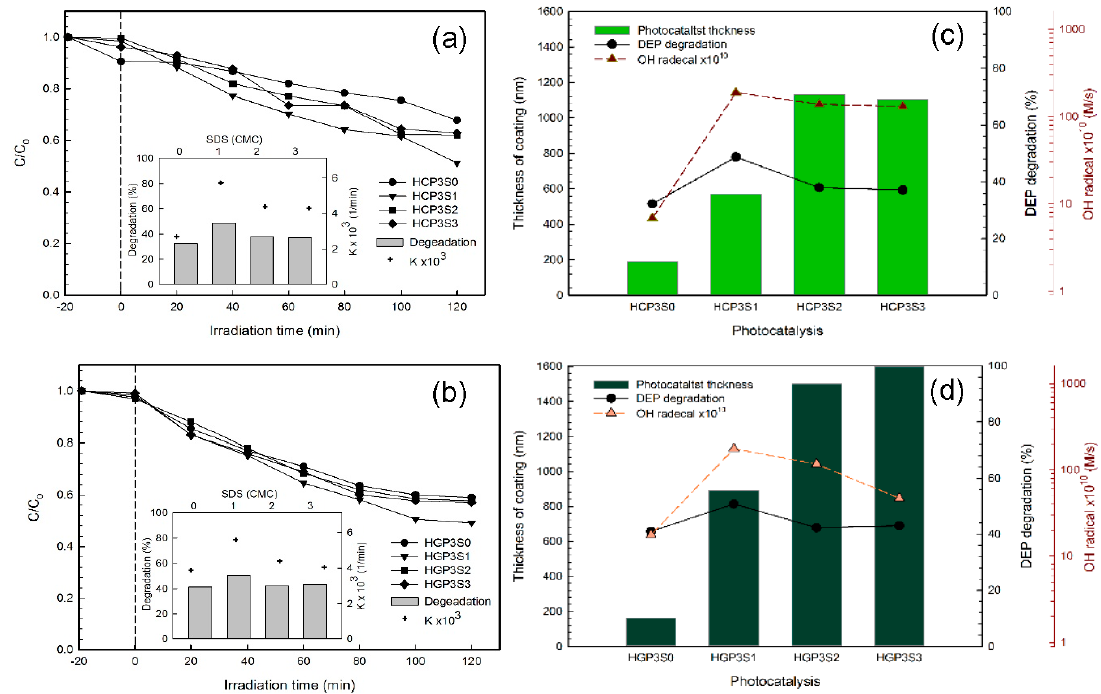
Figure 8. ( a , b ) Photo-degradation of DEP by hydrothermally-synthesized photocatalysts ([DEP] 0 = 1 mg/L; pH = 7; λ = 410 nm; I = 40 mW/cm 2 ; Irradiation time = 120 min); ( c , d ) Photo-degradation efficiency of DEP by hydrothermally-synthesized photocatalysts vs. hydroxyl radical generation and coating film thickness.